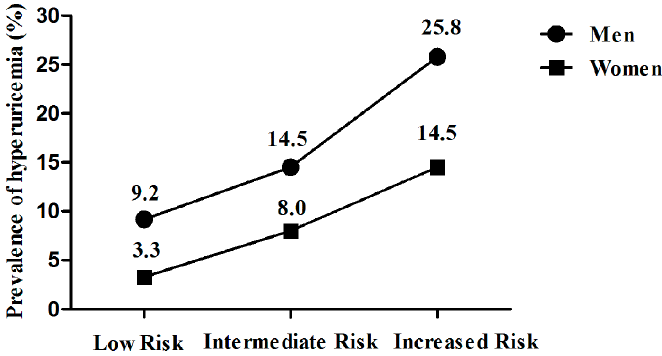
Figure 2. The prevalence of hyperuricemia in the three groups of AIP classified by sexes.